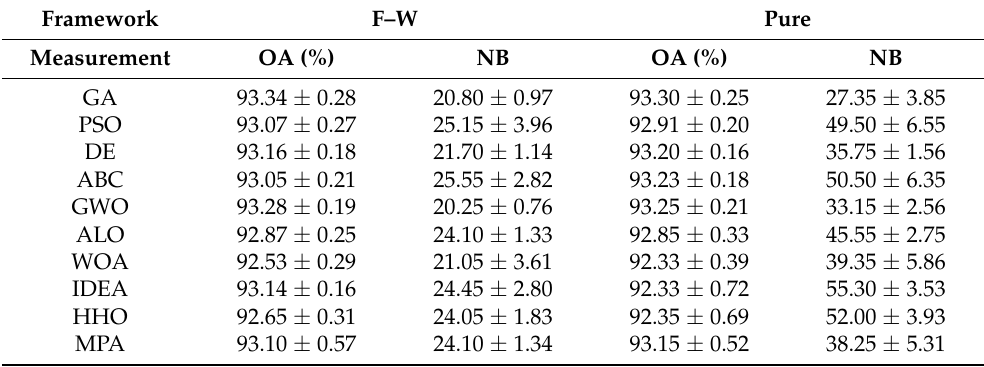
Table 3. The OA and NB of different algorithms on the Salinas dataset. Framework